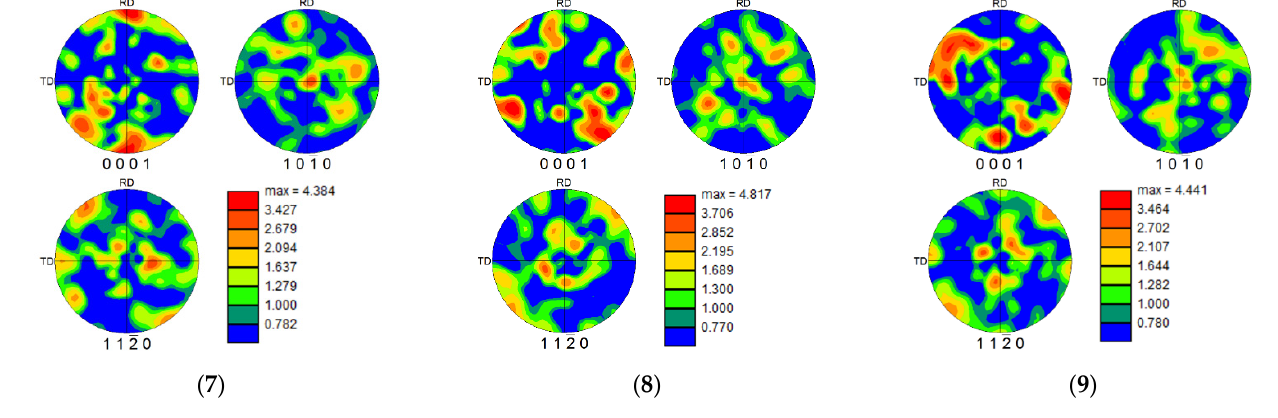
Figure 13. Pole figures of the Ti-6Al-4V surface under different milling parameters. In Figure 14, the red line, green line, yellow line, and blue line represent the twin